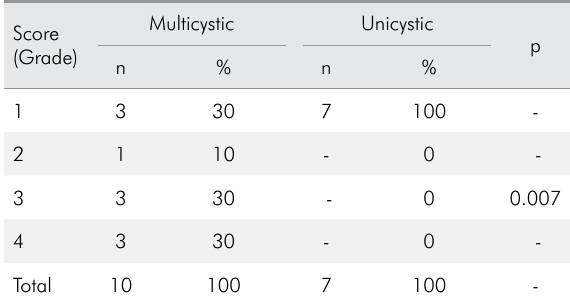
Table 3. Diferences in P75NTR expression in multicystic and unicystic